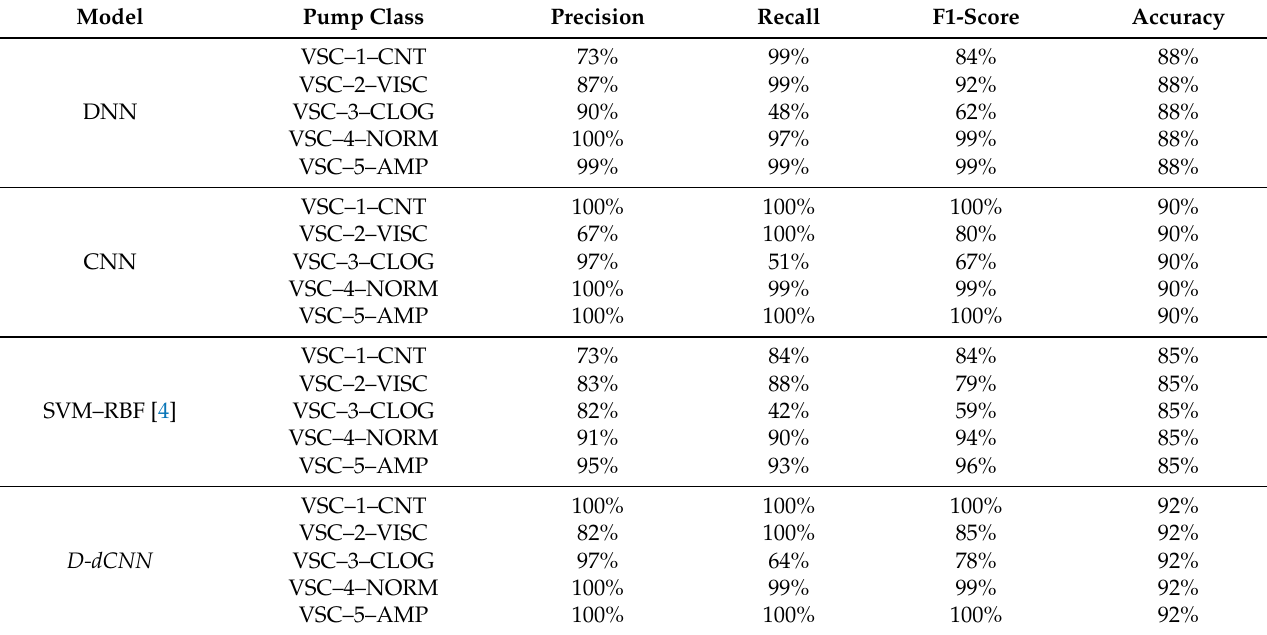
Table 3. Classification performance summary of diagnostic models on each operating conditions.